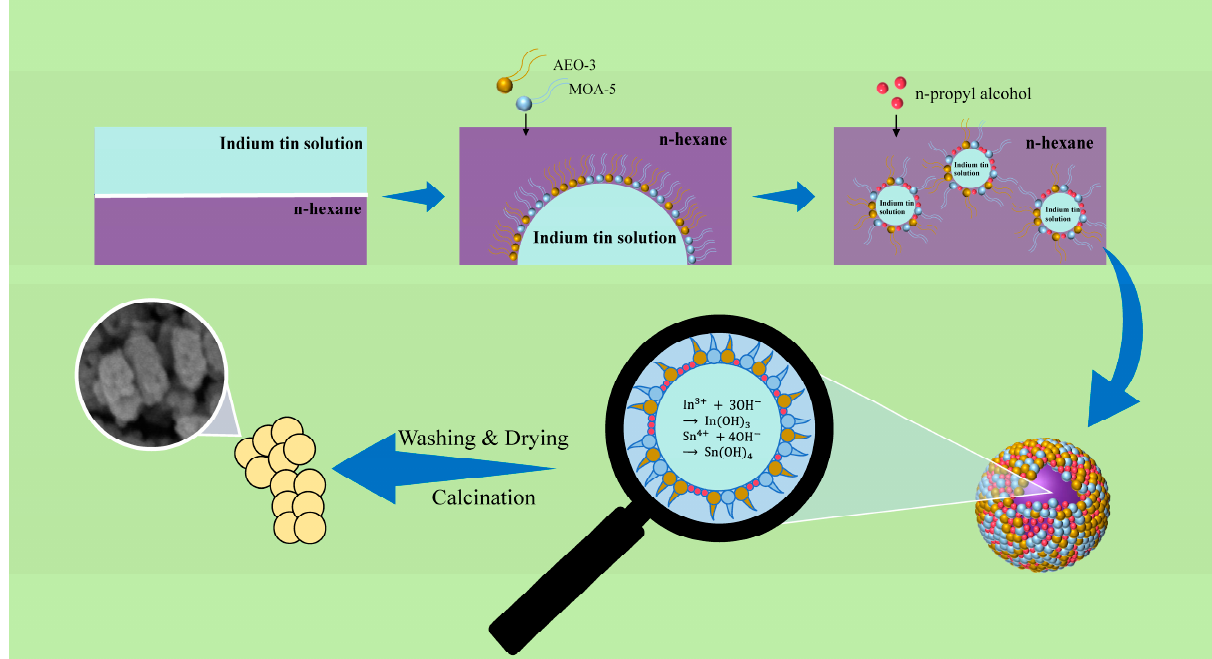
Figure 6. Preparation mechanism of ITO nanoparticles using the microemulsion method.